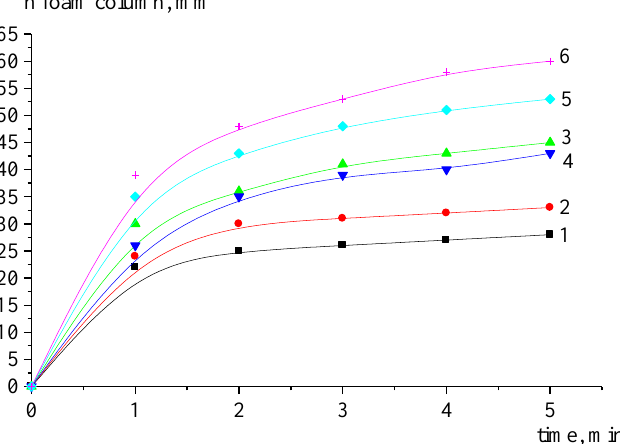
Figure 7. Foaming ability of T-92 (1,2,3) and BTF-163 (4,5,6) at different concentrations: (1) C = 0.05% (0.5 g/dm 3 ); (2) C = 0.5% (5 g/dm 3 ); (3) C = 5% (50 g/dm 3 ); (4) C = 0.05% (0.5 g/dm 3 ); (5) C = 0.5% (5 g/dm 3 ); 6) C = 5% (50 g/dm 3 ).